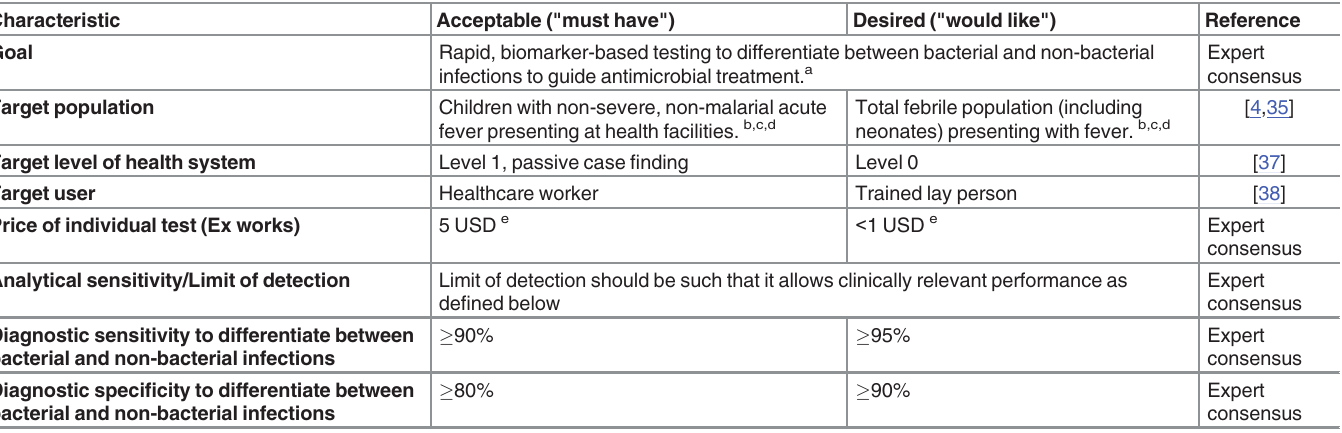
Table 2. Acceptable and desired target product profile characteristics focused on the scope of the test, as defined by an expert consensus pro- cess 2015 – 16. Characteristic